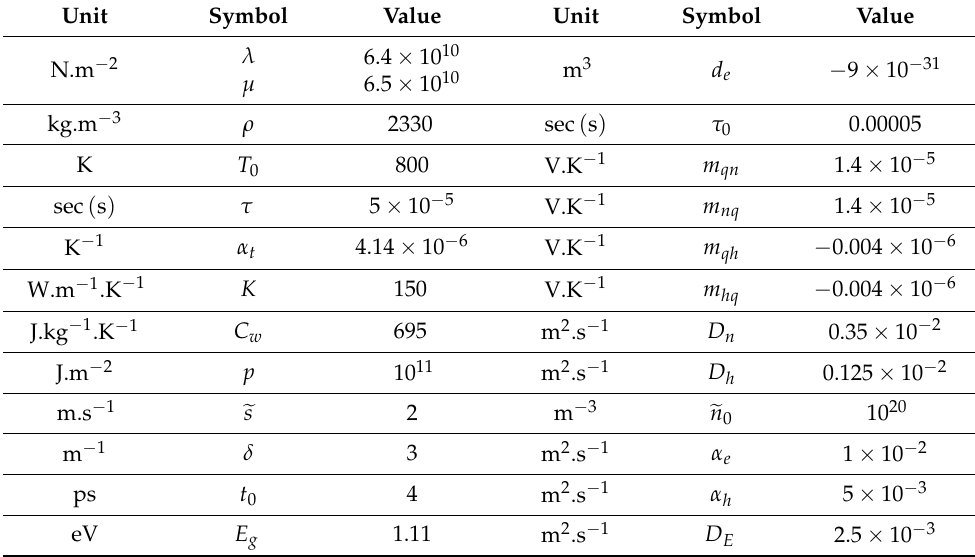
Table 1. The physical constants in SI units of Si material.